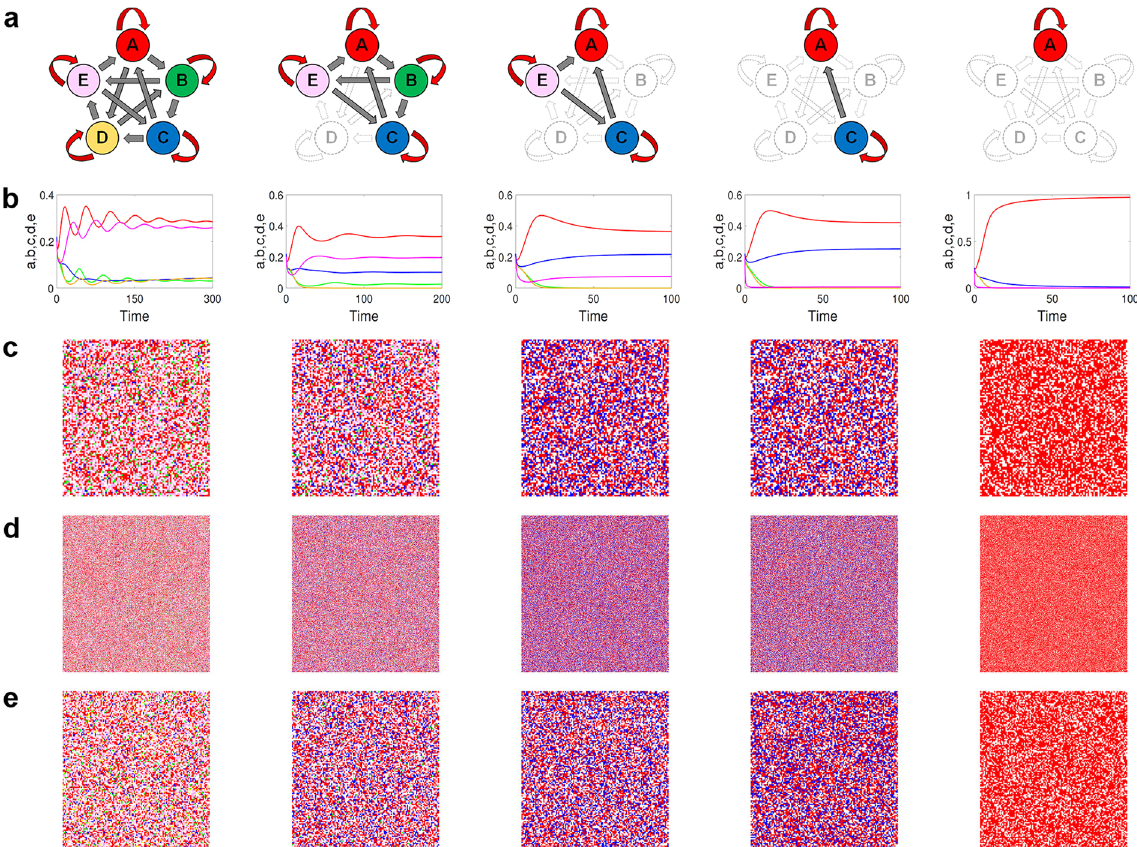
Figure 5. Coexistence states in RPSLS game. ( a ) Five different types of surviving species, where each color denotes a different species (blank for empty site). The four columns from left correspond to four different values of the intraspecific competition rate of one species: p e = 2.2, 3.3, 9.3 and 100, respectively, with fixed parameters p a = 0.3, p b = 1.1, p c = 2.5 and p d = 0.7. For example, in the left most column, ( b ) is the density evolution from the ODE model, ( c , d ) are typical snapshots obtained from Monte Carlo simulations of lattice size N = 100 × 100 and 500 × 500, respectively, and ( e ) is a snapshot obtained from the PDE model. The right most column is for p a = 0.01, p b = 1.1, p c = 2.5, p d = 0.7, and p e =